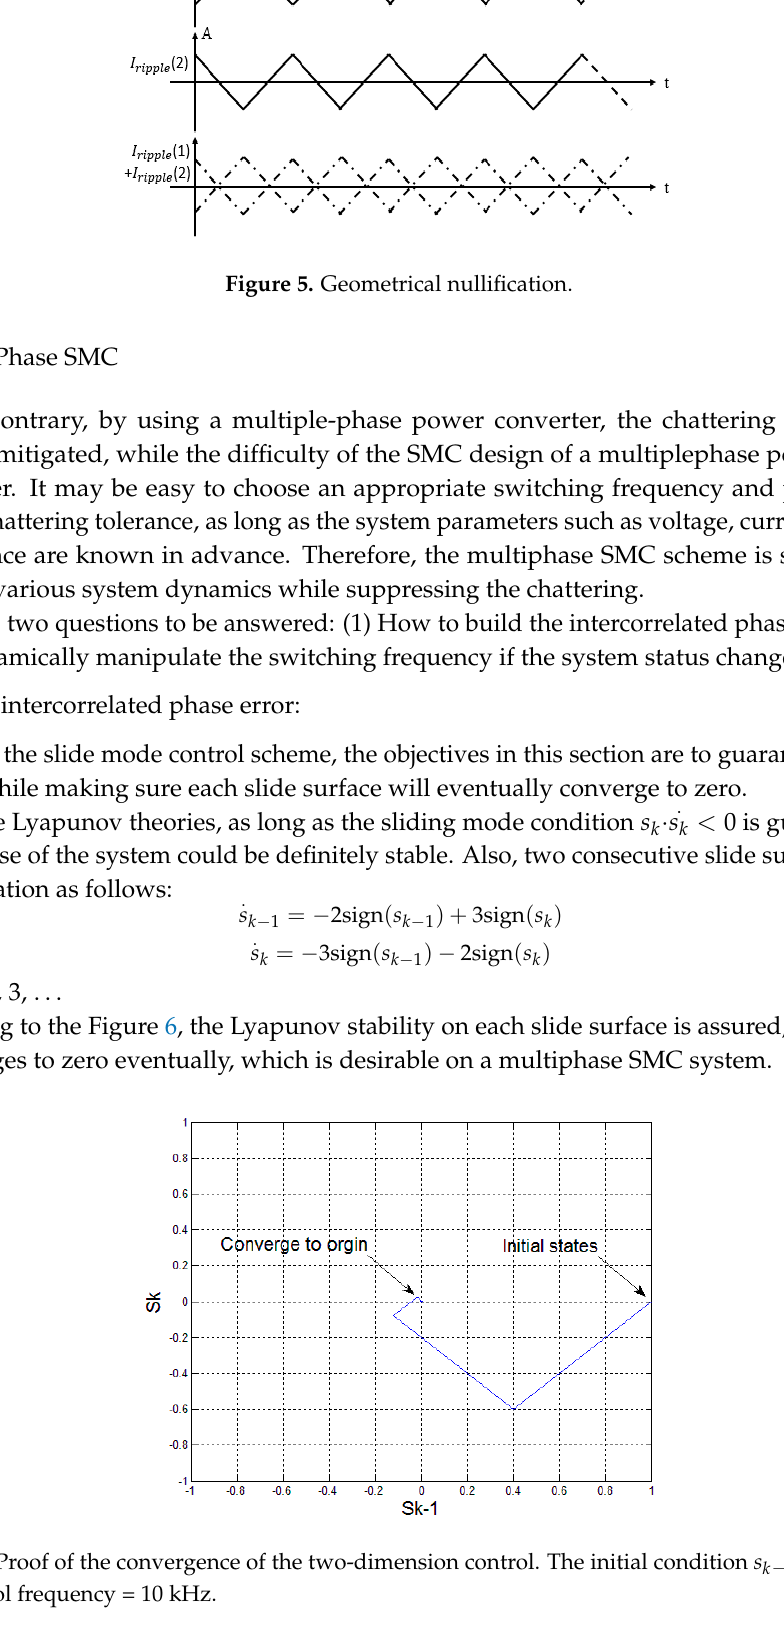
Figure 5. Geometrical nullification.